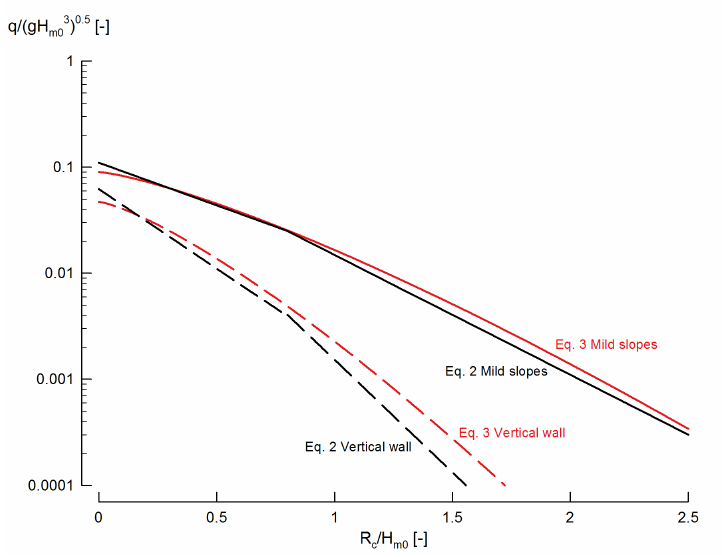
Figure 3. Comparison of overtopping prediction between Victor and Troch [10] (Equation (2)) and van der Meer and Bruce [11] (Equation (3)) for mild slopes (cot α > 2) and vertical walls (cot α =